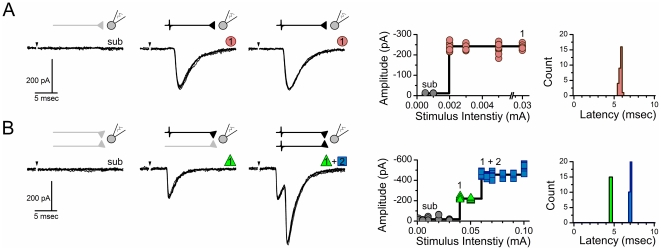
Incremental stimulus recruitment curves differentiate between single and multiple monosynaptic ST-NTS contacts.Increases in shock intensity to the ST triggered fixed latency glutamatergic EPSCs with added complexity of waveforms. The fixed latency is consistent with recruitment of added single afferent inputs. A) Representative neuron that received a single input that was unaffected by further increments in shock intensity consistent with a lack of convergent addition axons (model organization, above. The recruitment profile for such responses showed a single sharp intensity threshold and a plateau of constant amplitude despite substantial higher stimulus strength. The latency histogram showed a narrow band of values from which jitter is calculated. B) In other neurons, raising shock intensity activated additional synaptic responses and in this case this added EPSC arrived at a later time but with low jitter. The recruitment profile for such compound responses showed additional sharp intensity thresholds with narrow plateaus of constant amplitude for each convergent input. The equivalent pathway circuit suggest two parallel ST afferents converging on the same ST neuron. Note that thresholds were precise and ‘all-or-none’ over limited intensity ranges making each component response consistent with unitary contributions adding to the more complex EPSC.